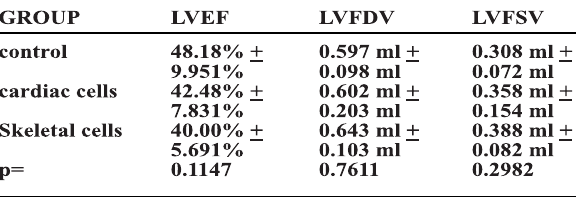
Table 1. Base mean echocardiographic values